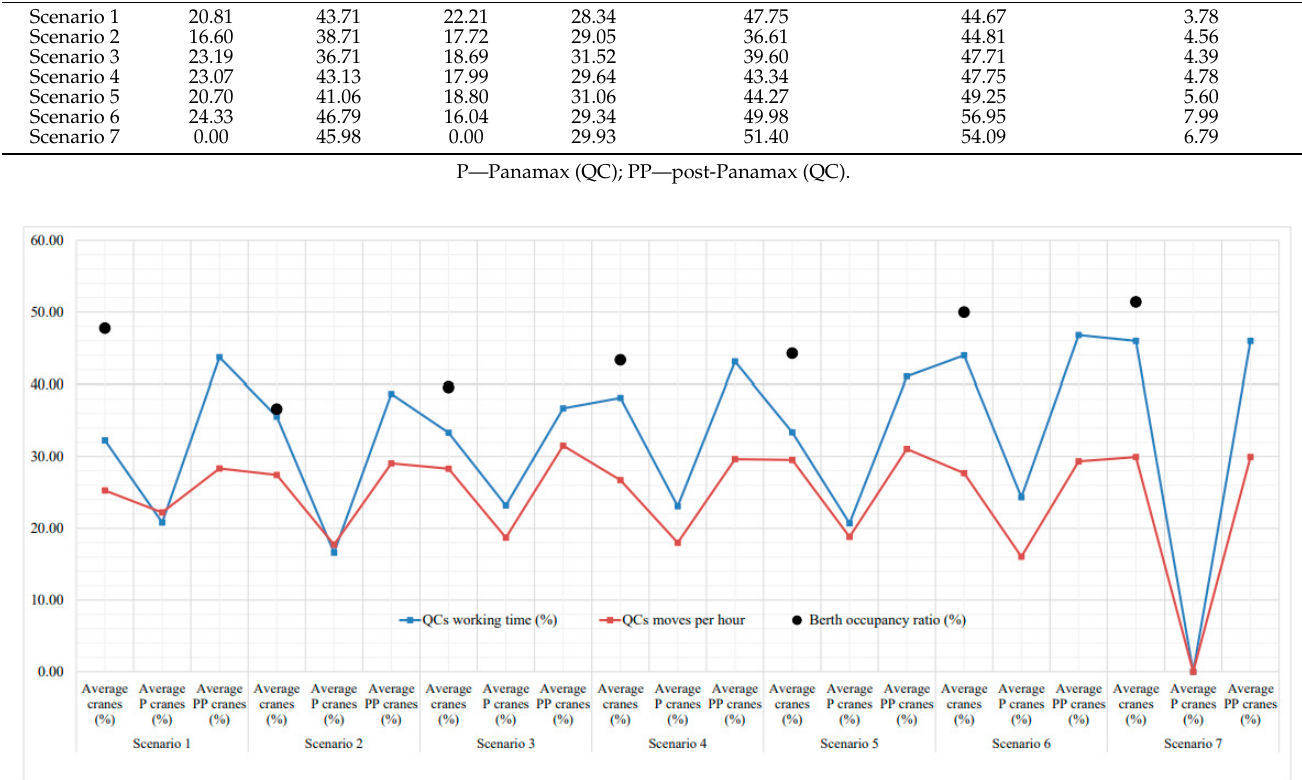
Figure 6. Graphical view of the yard results. The results show that at the berth subsystem, both QC types performed all tranship- ment operations with an extremely low work ratio that never exceeded the recommended work ratio, which still allows for smooth vessel operation. This is especially important in the last two scenarios where the traffic volume at the terminal is the highest. There, the working time of the post-Panamax QCs did not exceed 47%. This had a very positive effect on the vessel operating time and, of course, on the time the vessel spends in port and therefore on berth occupancy. This only varied between 36% and 51%, which means that there is still much space before the recommended limit of 65% is reached. It is extremely important that berth occupancy remained so low even in the last two scenarios where terminal traffic increased up to 1 million TEU per year. This means that it would be pos- sible to increase throughput even further without losing berth operating levels. Moreover, the productivity of the QCs reached the desired numbers. The overall average QC moves per hour were between 25 and 30, but if we focus only on the post-Panamax QCs, we find